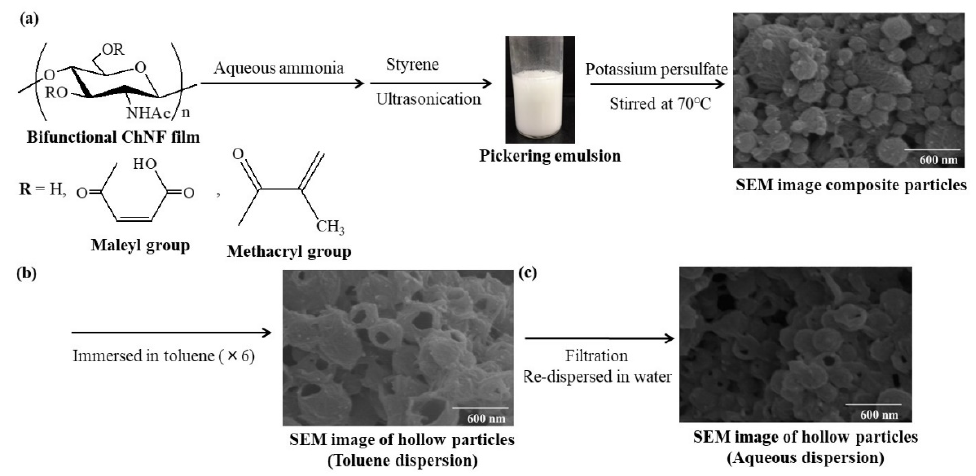
Figure 7. ( a ) Preparation of ChNF/polystyrene composite particles by Pickering emulsion polymer- ization; ( b ) conversion into hollow particles by treatment with toluene; and ( c ) redispersion of hollow particles in water.